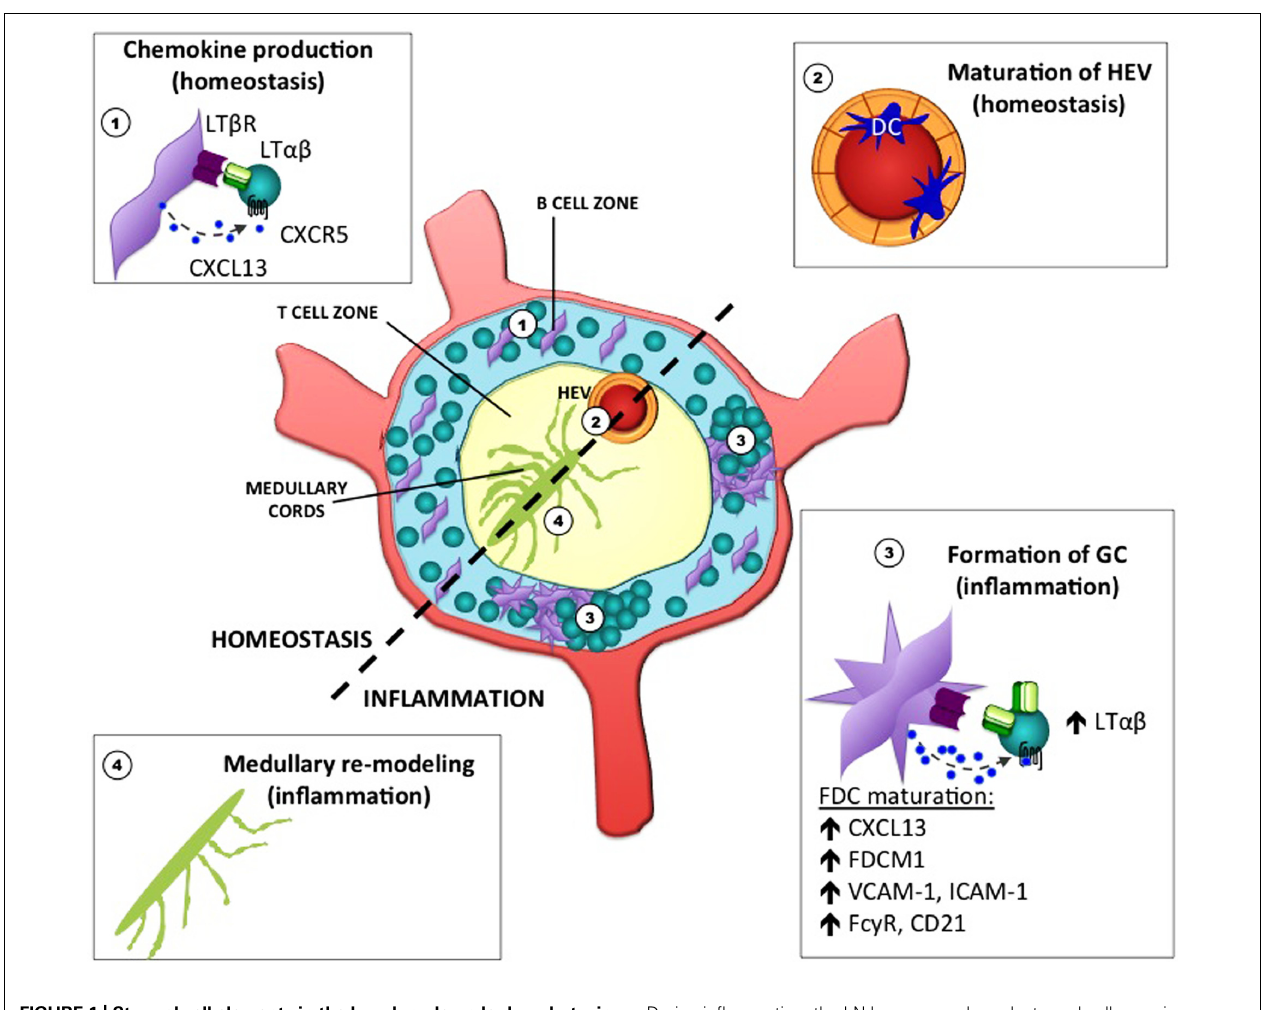
During inflammation, the LN becomes enlarged, stromal cells acquire new functions, and increased vascularization occurs (not depicted). In addition, clusters of B andT cells aggregate within germinal centers during T-dependent immune responses, and highly differentiated FDC within the GC environment require LT β R signaling (3).To facilitate the output of plasma cells that emerge from these GC reactions, remodeling of the medullary region has been shown to occur